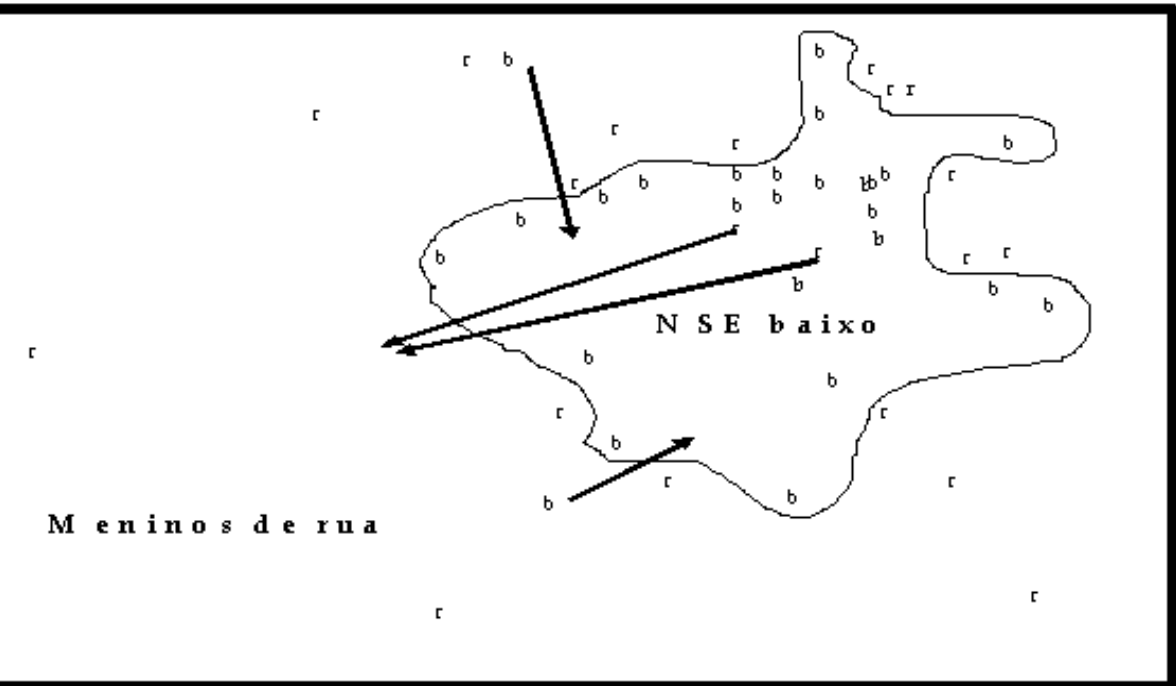
Figura 8 . Análise SSA comparativa entre os grupos NSE baixo e Meninos de rua a partir dos perfis relativos às ordenações das ocupações em função da